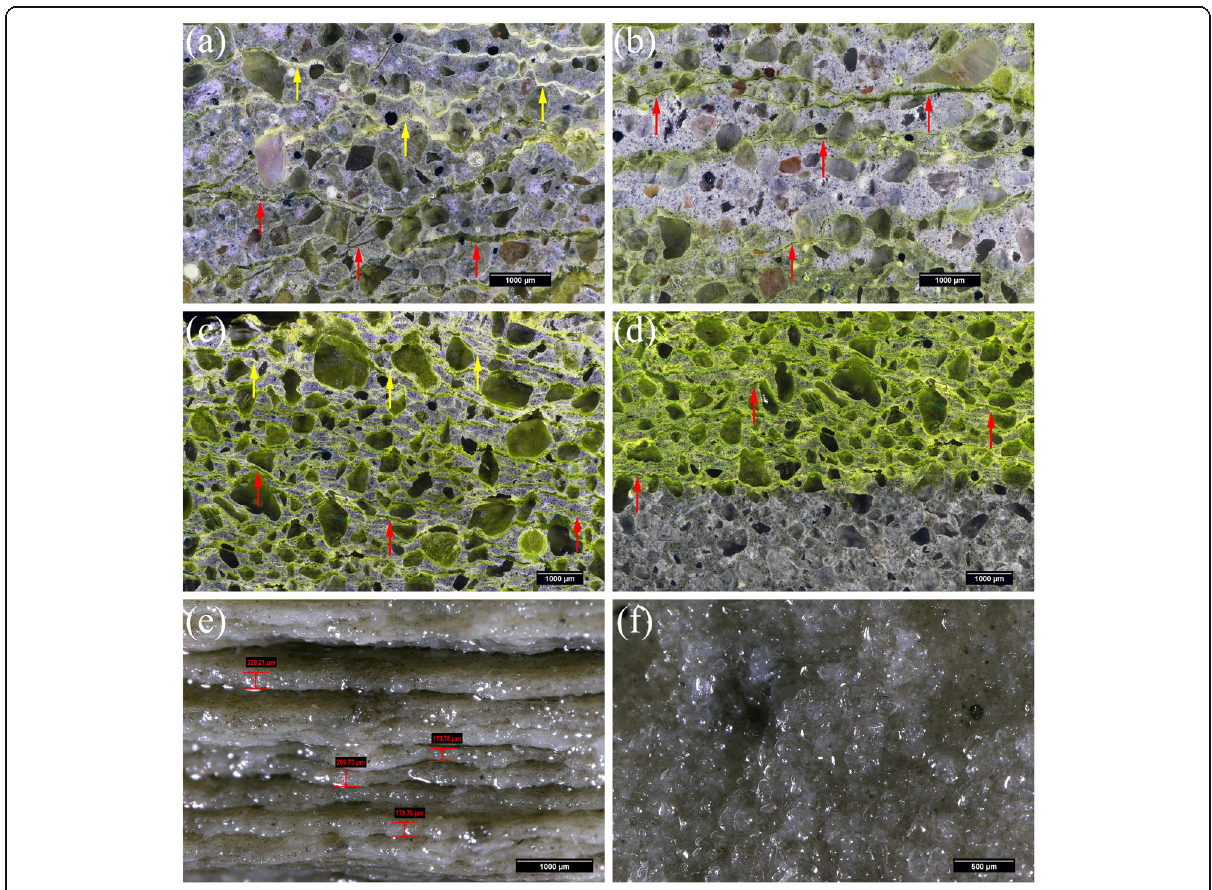
Fig. 4 a - d Reflected light photomicrographs of the polished surface of the damaged field mortar ( a and b ) and lab-cast mortar ( c and d ), respectively, showing horizontal cracks/microcracks at two different depths from the exposure surface. Zones in ( a ) and ( c ) are closer to the exposure surface. Yellow and red arrows indicate cracks/microcracks with and without secondary deposits, respectively. e Fresh delamination sheets in the damaged lab-cast paste. f Transparent secondary deposits on the surface of the delamination sheet in ( e